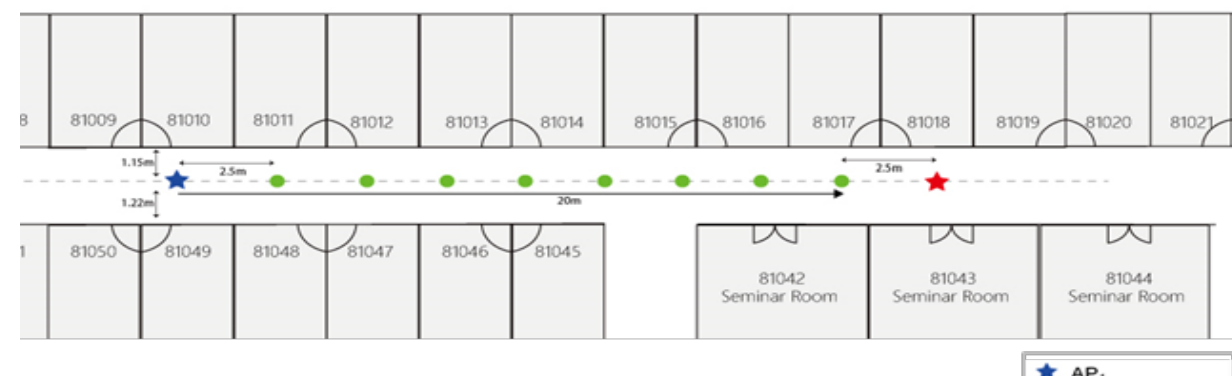
Figure 10. AP 1 and AP 2 location field plan